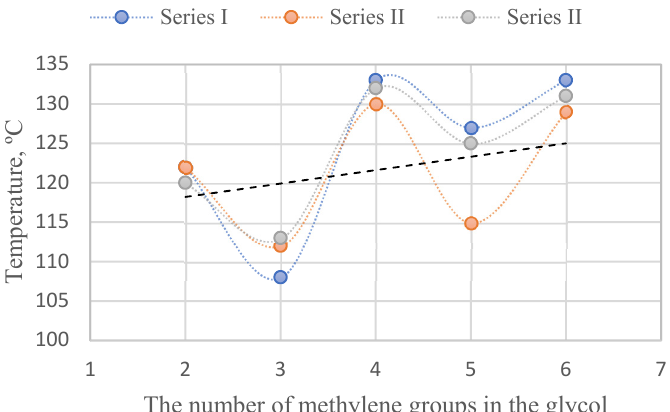
Figure 10. The parity rule of melting point of the terpolymers.